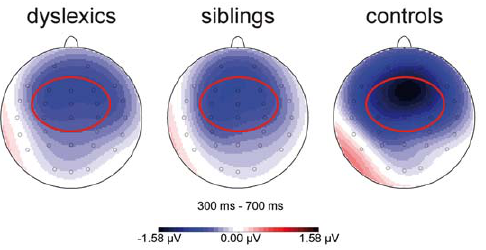
Figure 2. Topographic maps for the late MMN. Topographic maps for the time period 300–700 ms (late MMN) for dyslexic children, unaffected siblings, and unrelated controls, showing the ROI encircled in